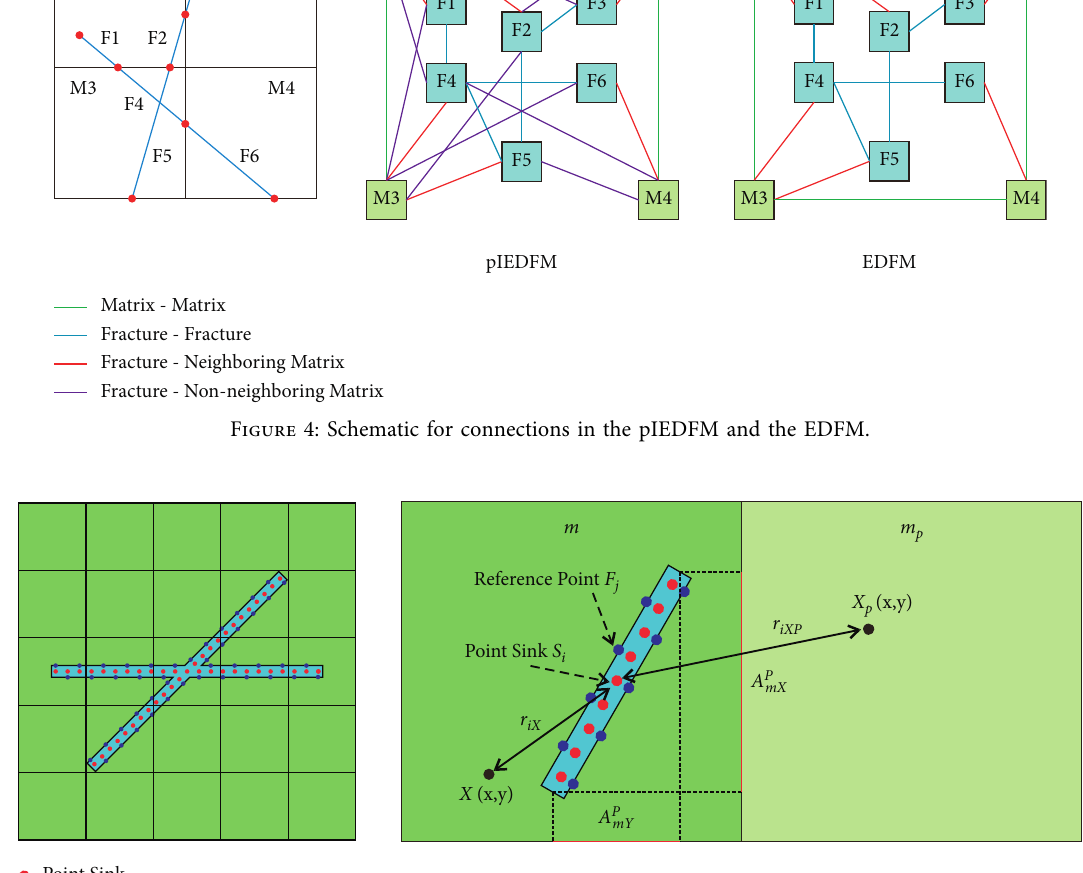
Figure 5: Schematic for the calculation of matrix-fracture